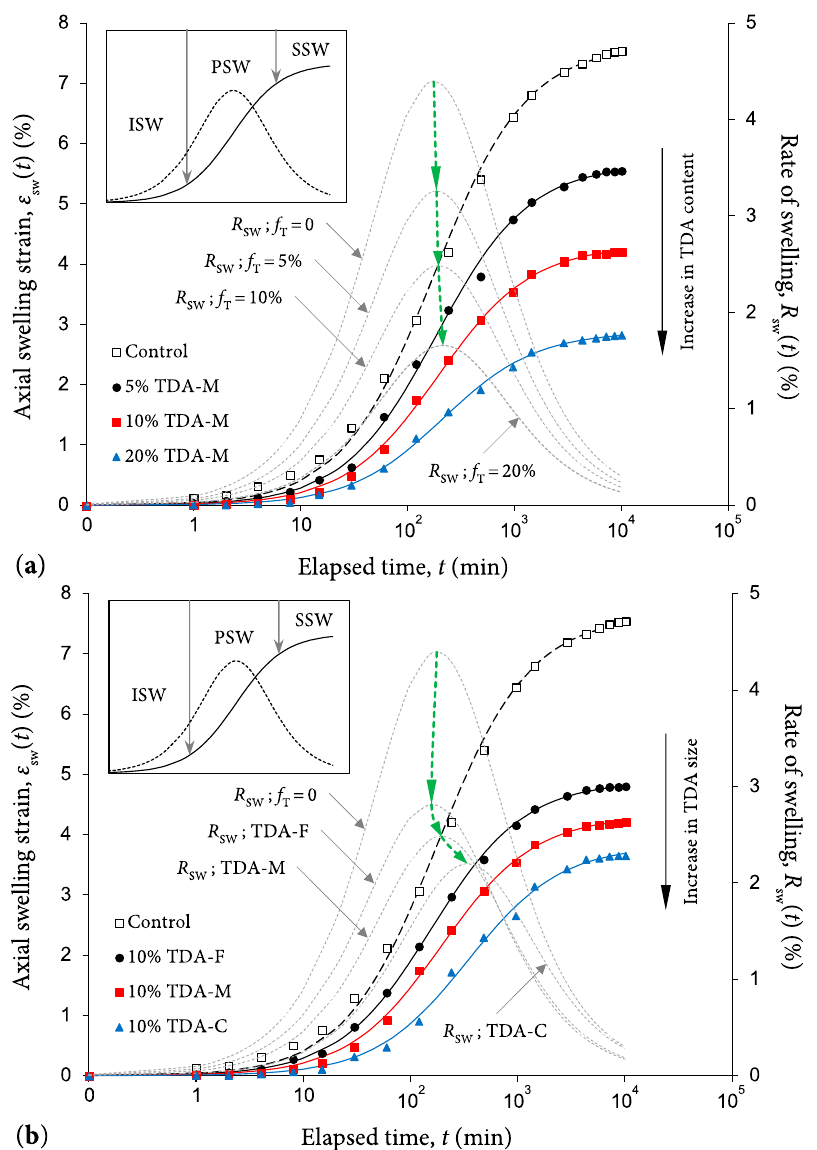
Figure 4. Typical swell–time relationships for the unamended test soil (control) and various soil–TDA blends: ( a ) TDA-M with f T = 5%, 10% and 20%; and ( b ) TDA-F, TDA-M and TDA-C with f T = 10%.